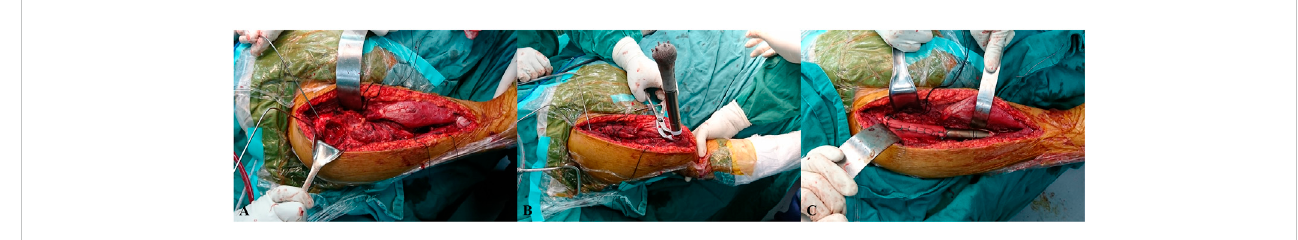
FIGURE 4 Intraoperative pictures. (A) The remaining proximal humerus was trimmed after segmental resection. (B) The prosthesis stem was press- fi t after assembly. (C) The prosthesis was implanted, and muscles were reconstructed using Marlex mesh.